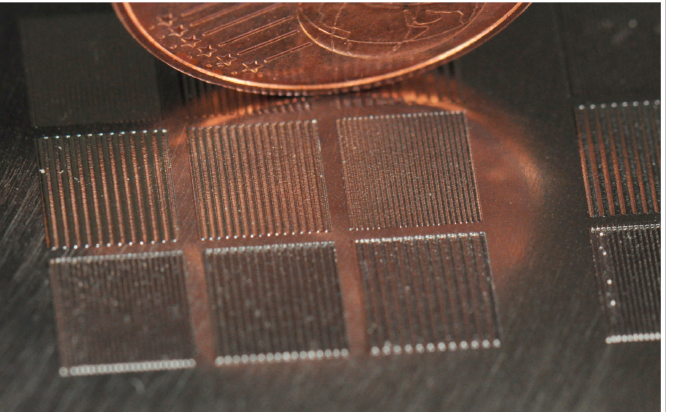
Figure 15. Photo of Ti6Al4V sample with various demo fields (5 × 5 mm 2 ) for areal structuring using small laser beam diameters and high scan speeds in the WaveShape process ( d L = 50 µ m, v scan = 200 mm/s, P M and P A adapted to v scan